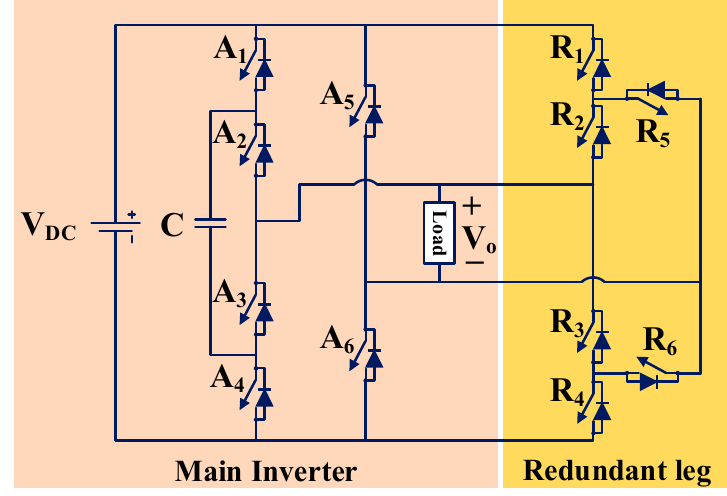
Figure 7. Single-phase five-level FT MLI (TP6) [3].